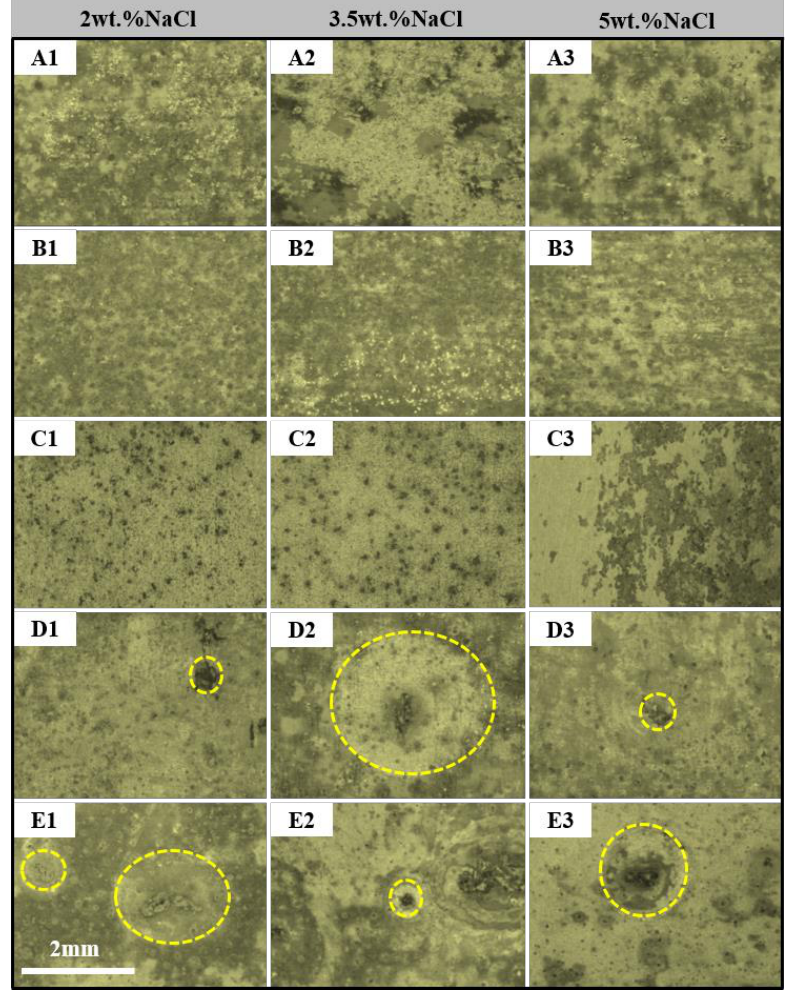
Figure 5. The macroscopic morphology of specimens immersed in different concentrations of NaCl solution for 14 days ( A : 2A97-T3; B : 2A97-T6; C : 2024-T4; D : 2060-T8; E : 2099-T83).